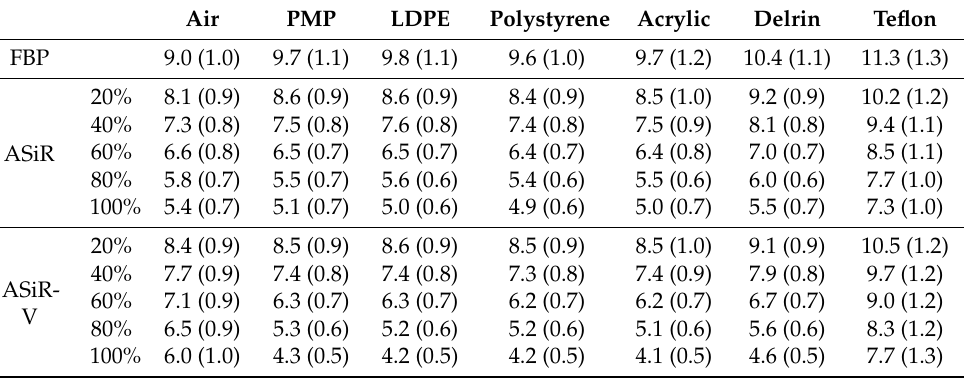
Table 3. CTP404 phantom module with different contrast objects (i.e., air, PMP, LDPE, polystyrene, acrylic, Delrin, Teflon). Summary noise level of each contrast object estimated as the mean (SD) value of N-FBP, N-ASiR, and N-ASiR-V maps within a central circular ROI of 1 cm